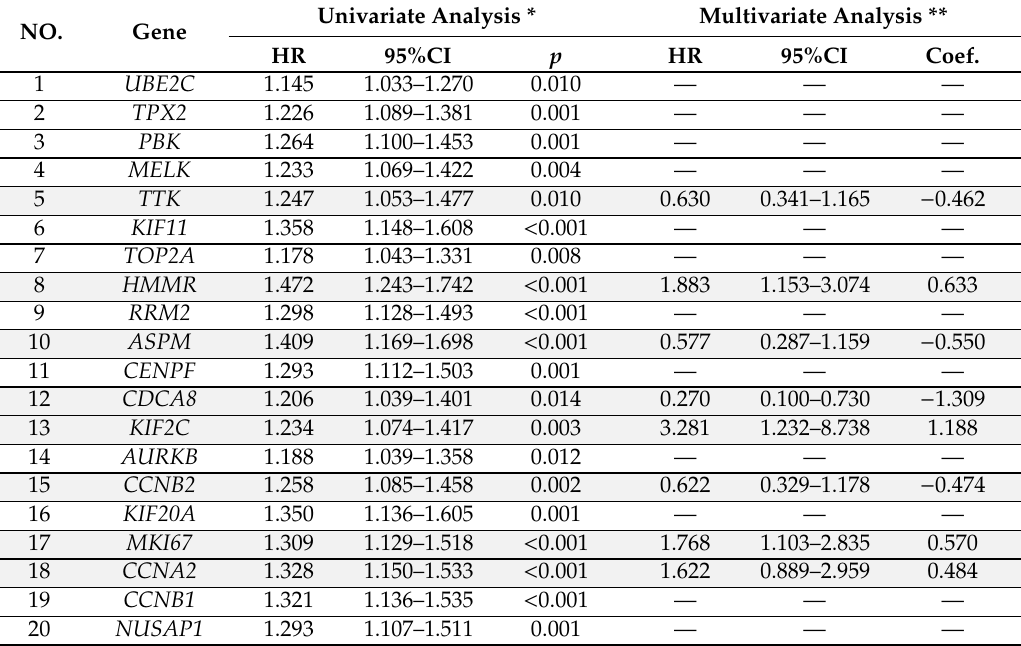
Table 3. Identification of gene expression signature by univariate and multivariate Cox regression analysis.